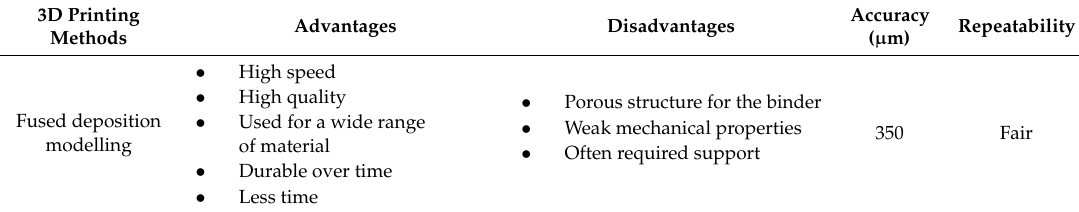
Table 2. Comparative study of the 3D printing methods in terms of their advantages, disadvantages, accuracy and